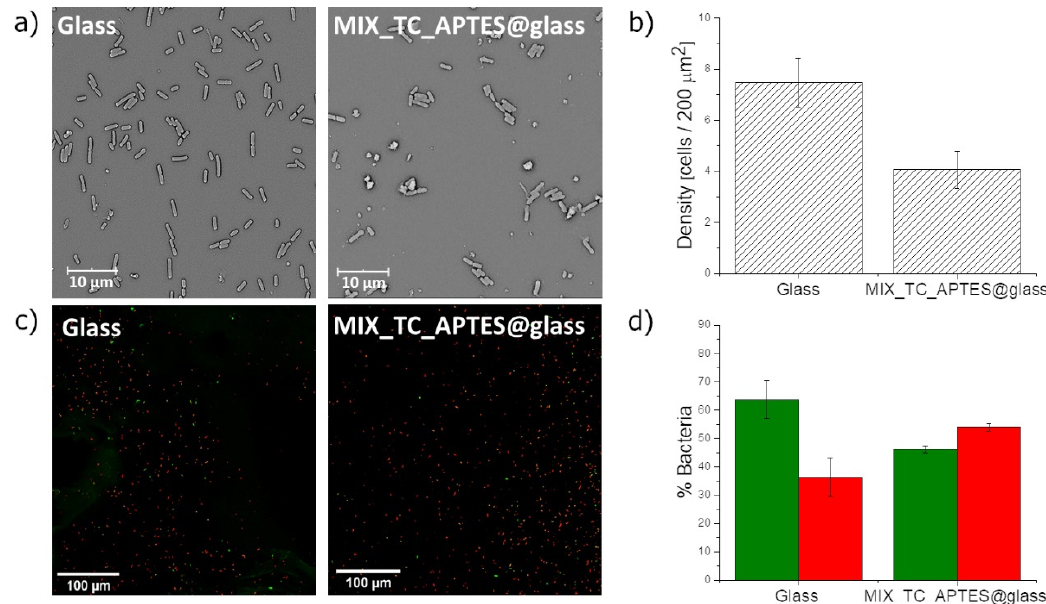
Figure 6. ( a ) SEM images showing E. coli present on the unmodified glass surface and MIX_TC_APTES@glass after 3 h; ( b ) the density of bacterial cells after 3 h determined from SEM for the unmodified glass and MIX_TC_APTES@glass surfaces; p < 0.05, n = 3; ( c ) confocal fluorescent microscope images showing E. coli on the unmodified glass and MIX_TC_APTES@glass surfaces after 3 h; ( d ) live and dead bacteria percentages after 3 h for the unmodified glass and MIX_TC_APTES@glass surfaces; p < 0.05, n = 8.